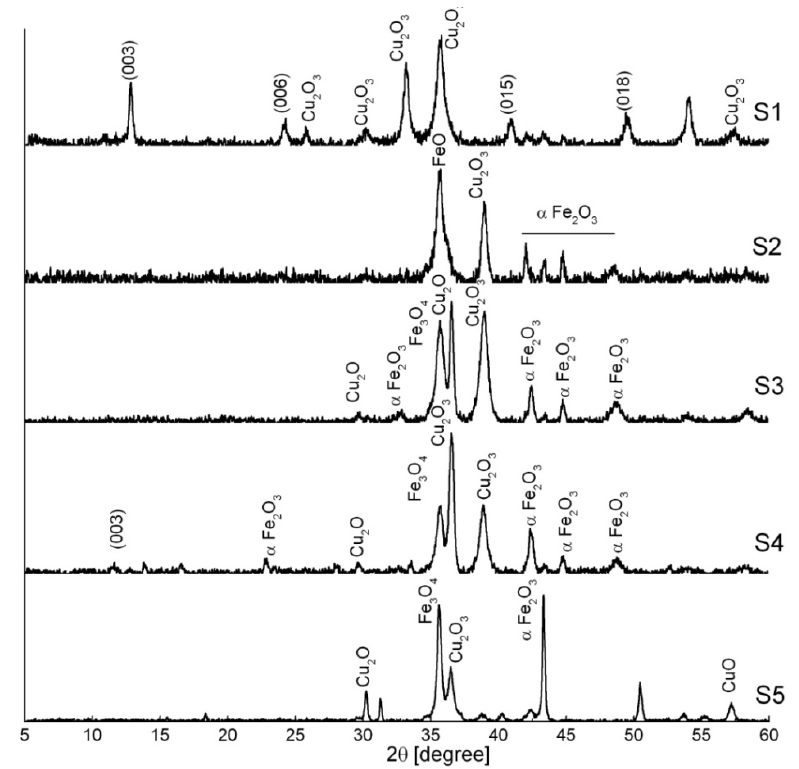
Figure 3. XRD patterns of synthesized powders.